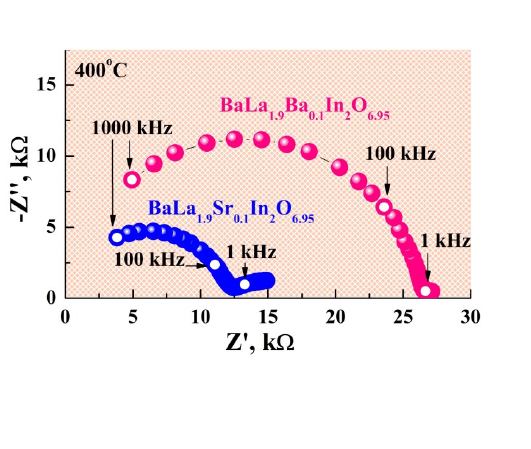
Figure 4. The EIS plots obtained at 400 °C for the compositions BaLa 1.9 Sr 0.1 In 2 O 6.95 and BaLa 1.9 Ba 0.1 In 2 O 6.95 ( a ) and temperature dependencies of conductivity for investigated compositions obtained under dry air ( b ).